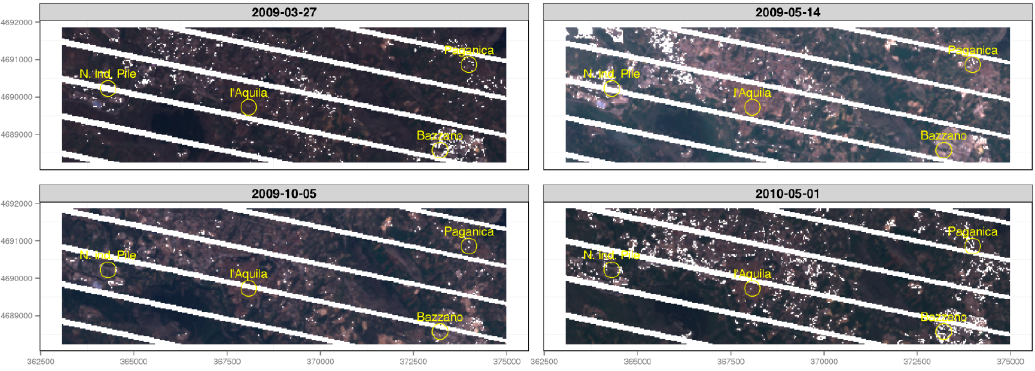
Figure 7. RGB composite of the four image-sets used for Land Surface Temperature estimation, with both SCL-off and cloud cover assessment masks. Images are around 12 km in width.